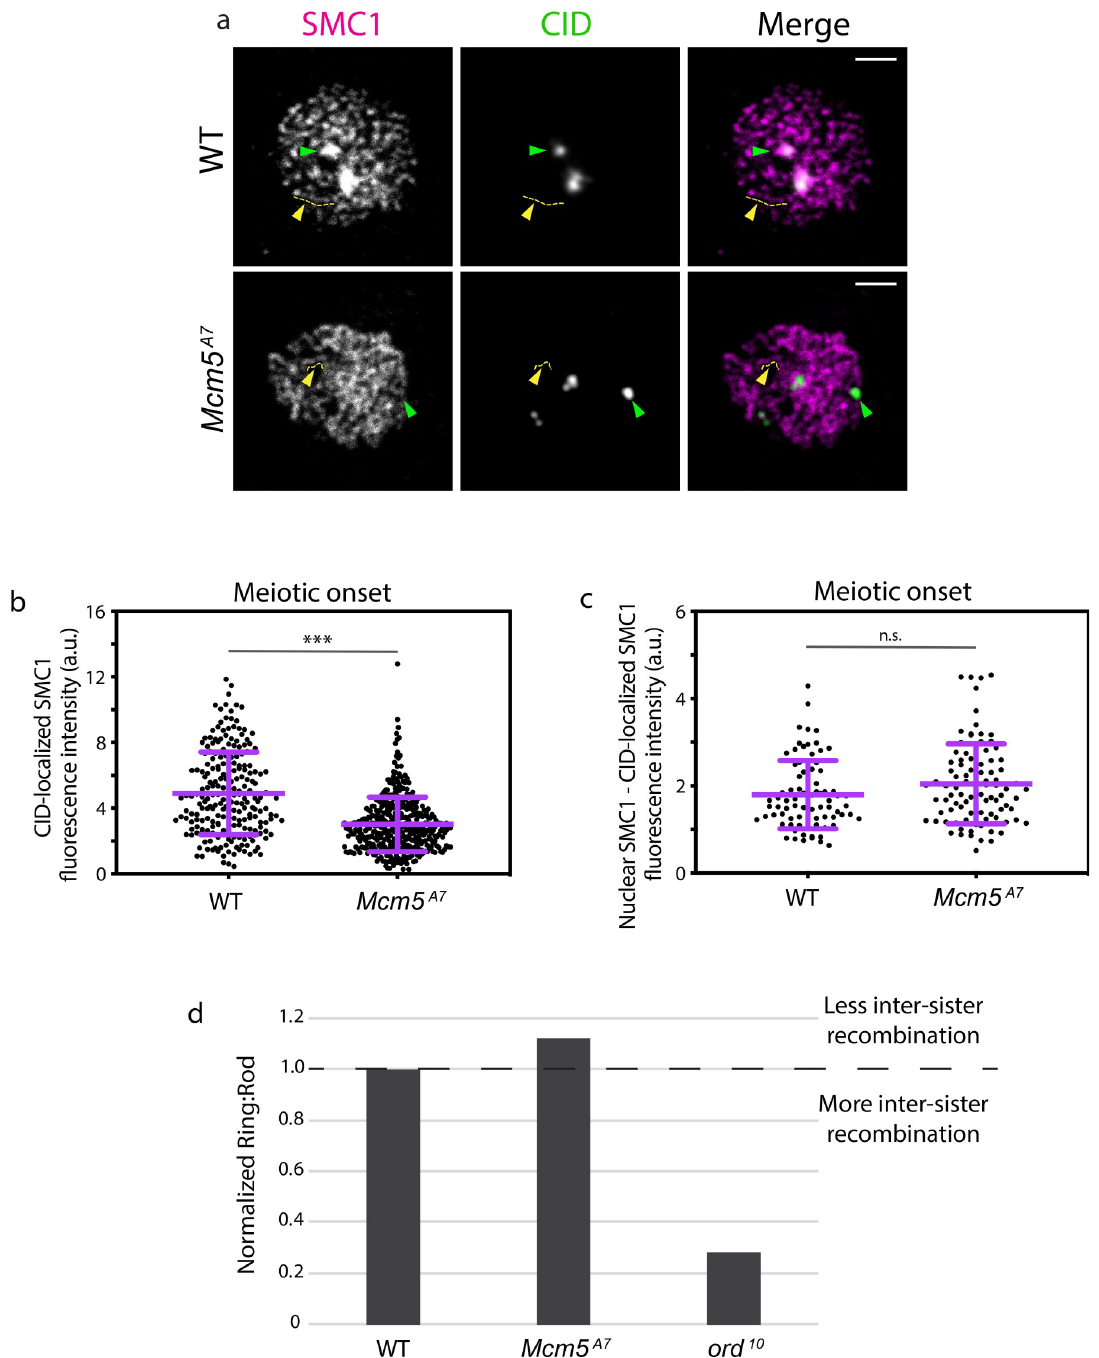
Fig 5. Centromeric SMC1 is significantly reduced in Mcm5 A7 mutants. a. Representative images of chromosome spreads in WT and Mcm5 A7 meiotic nuclei examining localization of SMC1 (magenta) and CID (green). Green arrow: SMC1 enrichment at the centromere, yellow arrow and tract: SMC1 along the chromosome arm. Scale bar = 2 μ m. Contrast and brightness of images were adjusted for clarity. b. Integrated SMC1 fluorescence intensity at CID foci in meiotic nuclei at meiotic onset (zygotene + early pachytene, Region 2A) at WT ( n = 225) and Mcm5 A7 ( n = 398) meiotic centromeres. ��� p < 0.0001, unpaired T-test. Data are represented as mean ± SD. c. CID-localized SMC1 fluorescence intensity subtracted from total nuclear SMC1 fluorescence in meiotic nuclei at meiotic onset (zygotene + early pachytene, Region 2A) in WT ( n = 81) and Mcm5 A7 ( n = 93) meiotic nuclei. n . s . = 0.0548, unpaired T-test. Data are represented as mean ± SD. S3A Fig for representative images. d. Mcm5 A7 ( n = 1194) and ord 10 ( n = 250) mutants examined for inter-sister recombination through the ratio of Ring chromosome to Rod chromosome transmission.